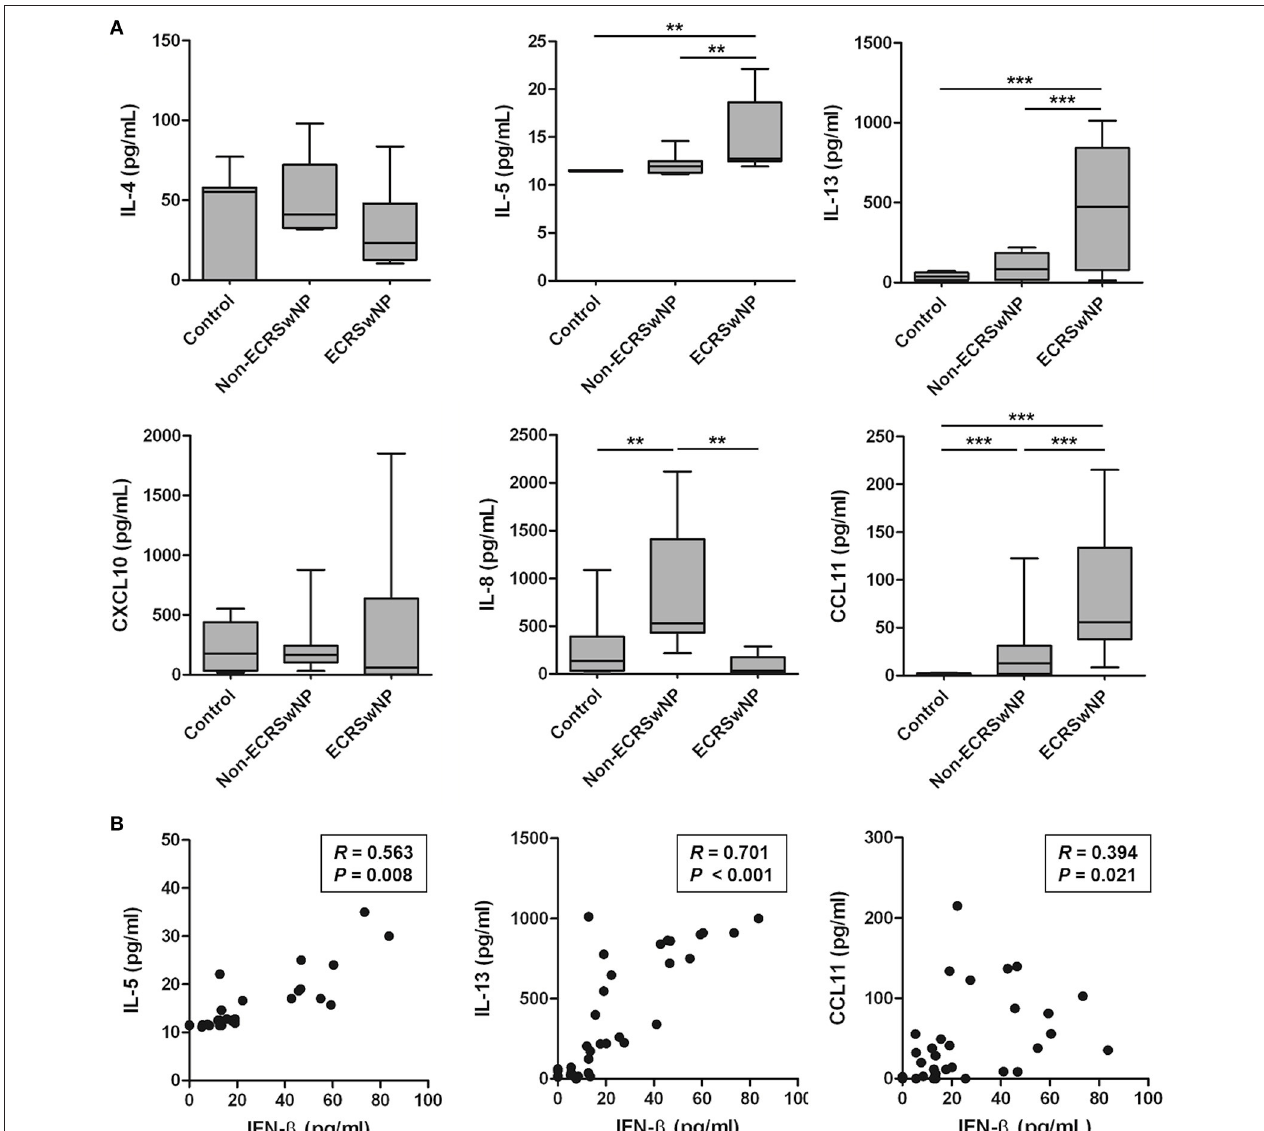
FIGURE 2 | Production of type 2 cytokines and eosinophil chemokines in human sinonasal tissue homogenates. (A) IL-5, IL-13, and CCL11 production was increased in the tissue homogenates from eosinophilic CRS with NP (ECRSwNP). (B) There is a significant positive correlation of IFN- β with IL5, IL-13, or CCL11. Horizontal bars indicate the medians. ** P < 0.01; *** P < 0.001, repeated measurement ANOVA with Tukey’s multiple comparison test (A) and Spearman correlation test (B)